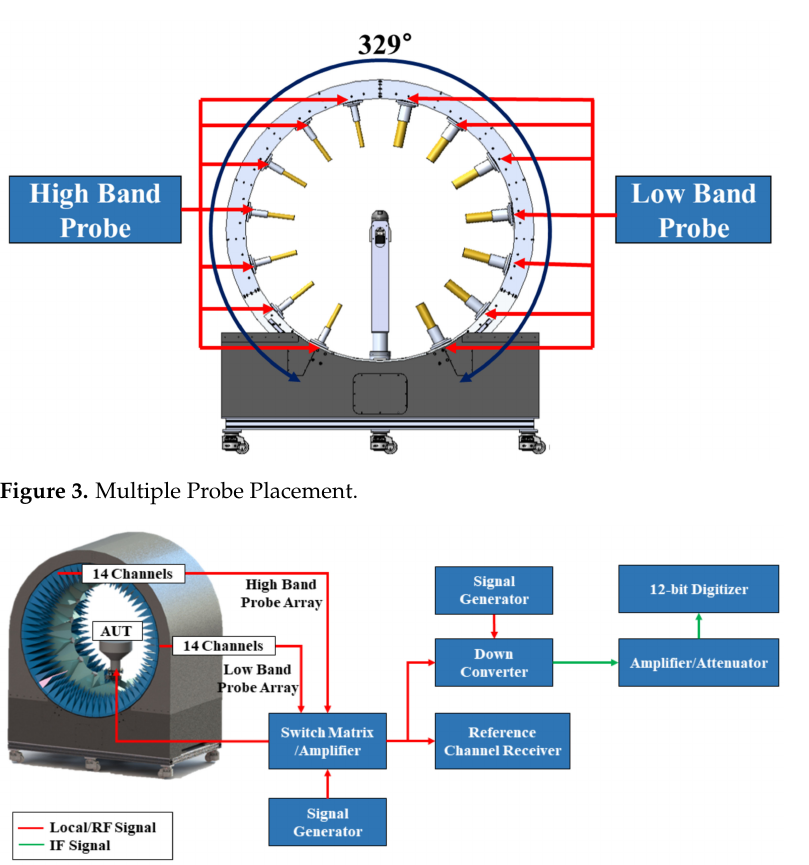
Figure 4. RF system block diagram.